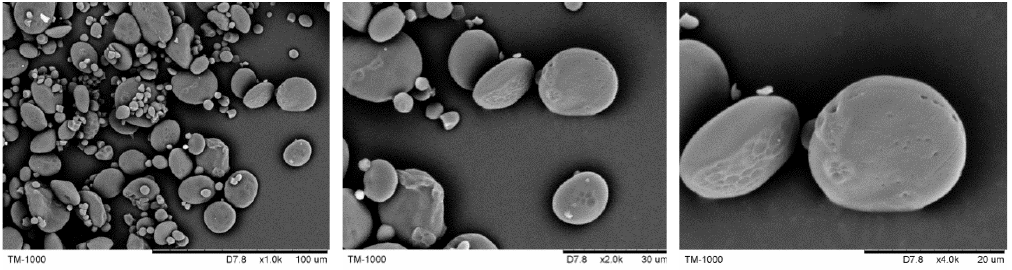
Figure 1. Scanning electron micrographs of starch obtained from wheat varying in grain hardness. From left to right, the starch granules were magnified at 1000×, 2000×, and 4000×, respectively.